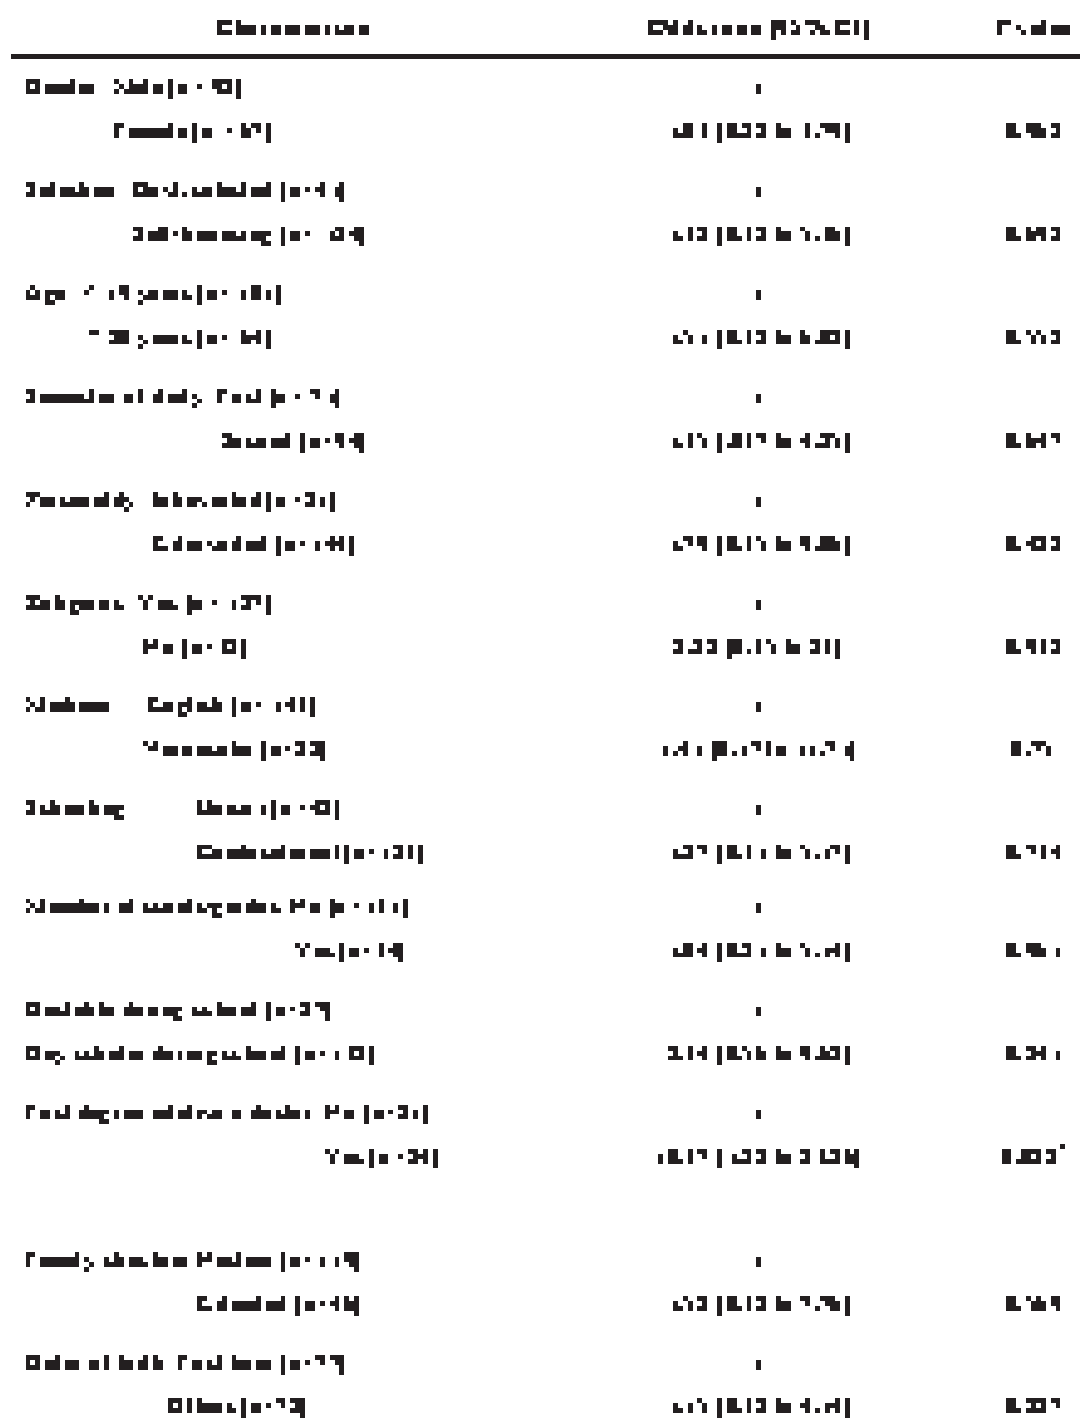
Table II : Demographic characteristics and factors associated with the average sharing score of student